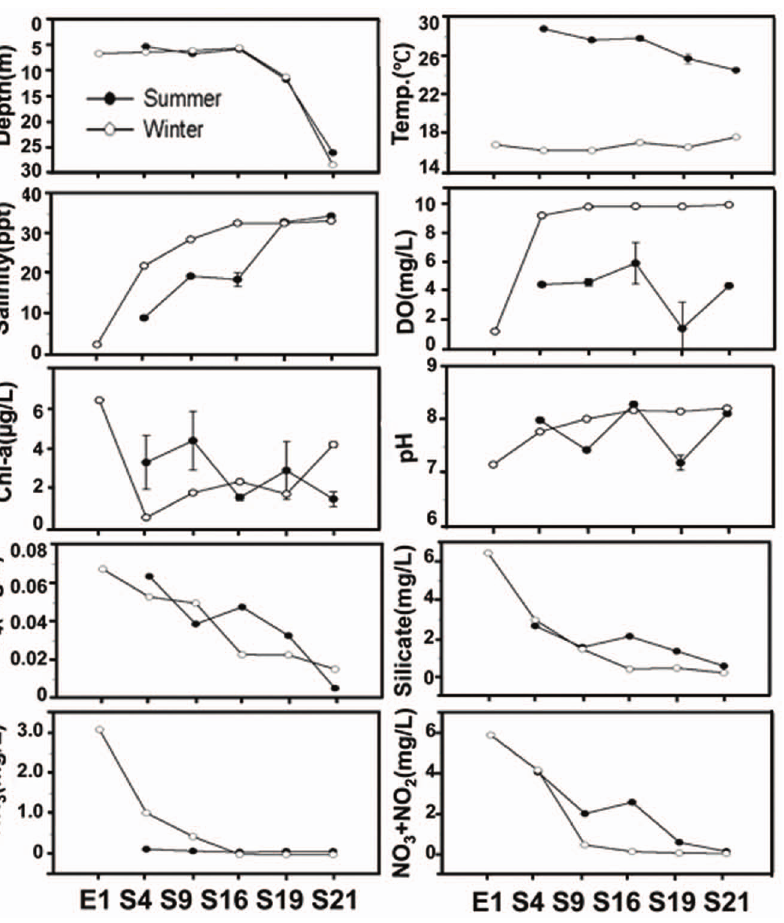
Figure 4. Environmental parameters measured from the overlying water. (a) Depth, (b) salinity, (c) temperature, (d) pH, and (e) dissolved oxygen were measured using a YSI. Nutrients, including (f) PO 4 , (h) SiO 4 , (i) NH 4 , and (j) NO 3 + NO 2 , were measured using a nutrient autoanalyzer. (g) Chlorophyll a (Chl a) content was determined with a fluorometer.